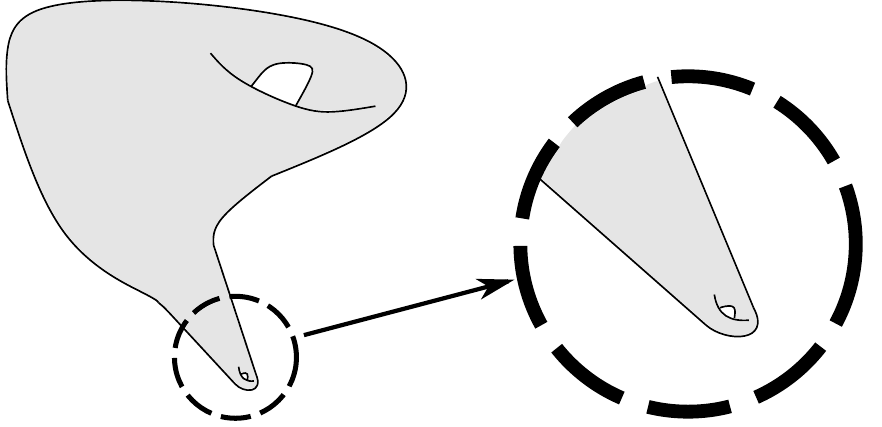
Figure 4 . Illustration of a Calabi-Yau manifold with a small blowup cycle. In the vicinity of the blowup, the geometry is assumed to resemble a